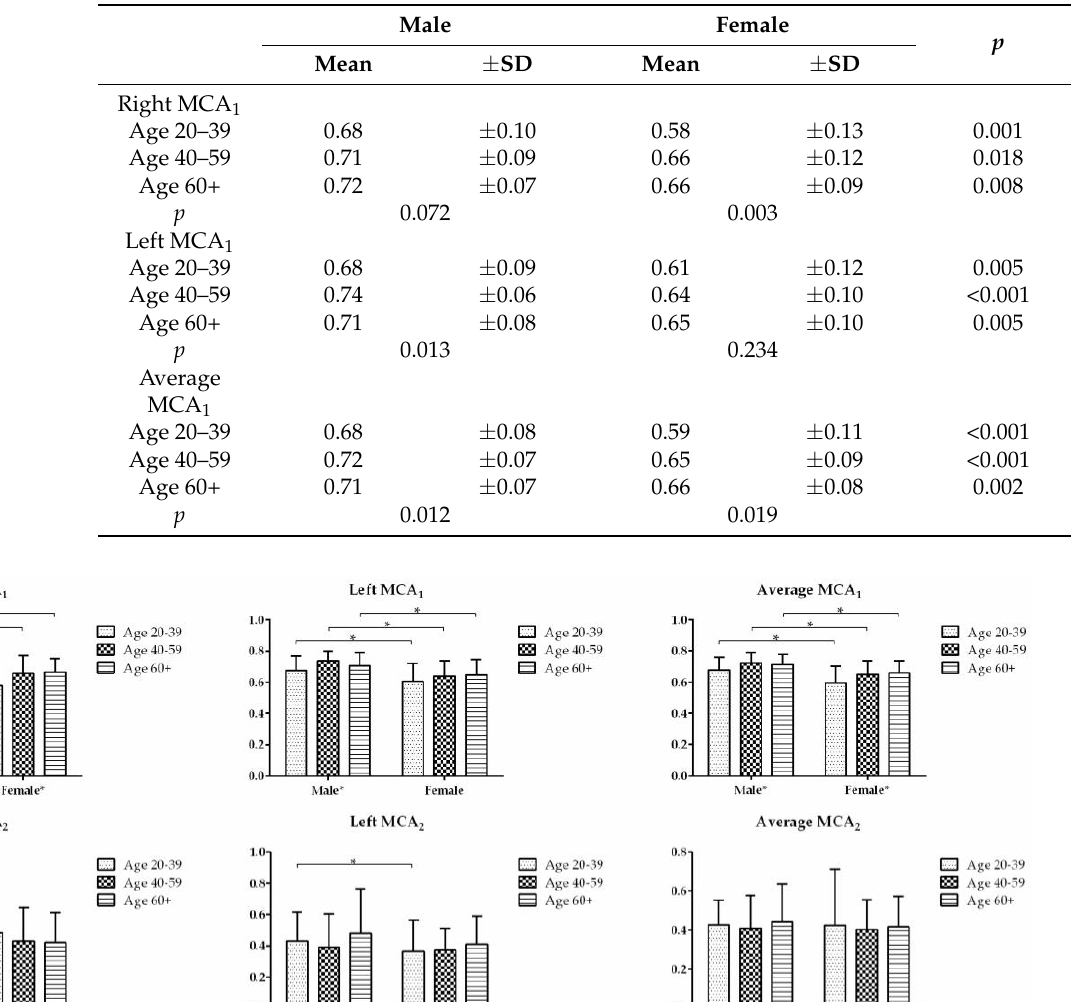
Table 3. First minimal cross-sectional area (MCA 1 ,cm 2 ).